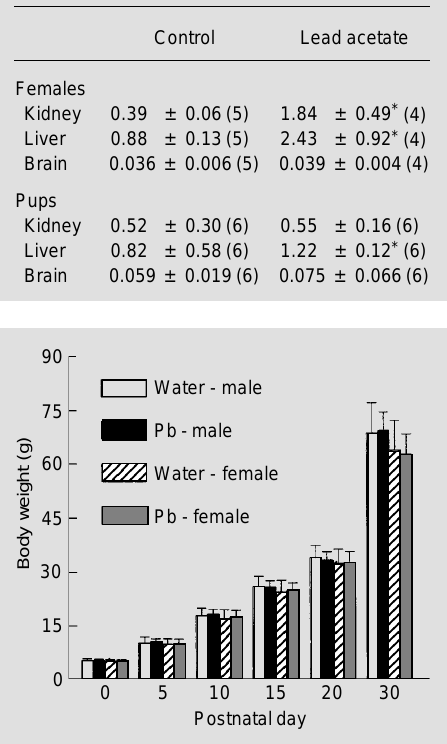
Table 1 - Renal, cerebral and hepatic lead content of female rats before mating and of pups after delivery. *P<0.05 compared to respective control (F values are presented in Results). Results are reported as means (ppm) ± SEM, and the number of animals is given in